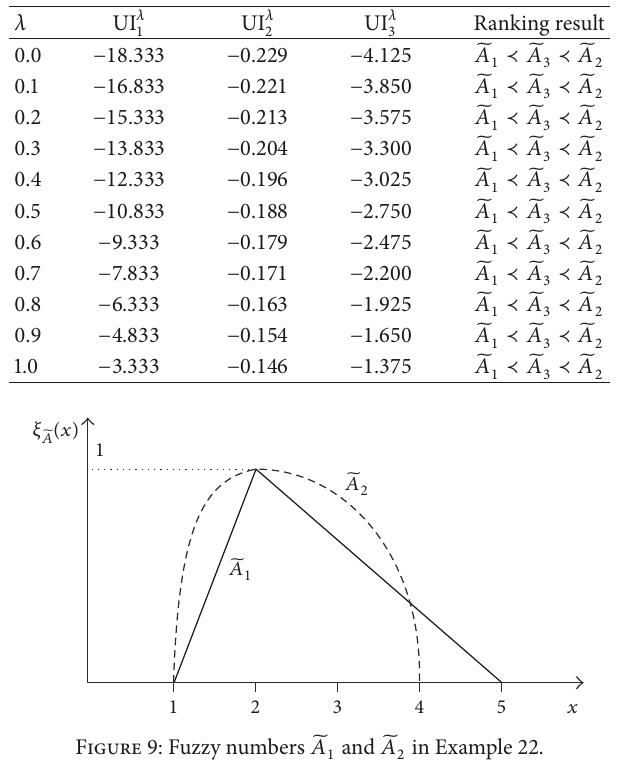
Table 8: Ranking results at different optimism levels in Example